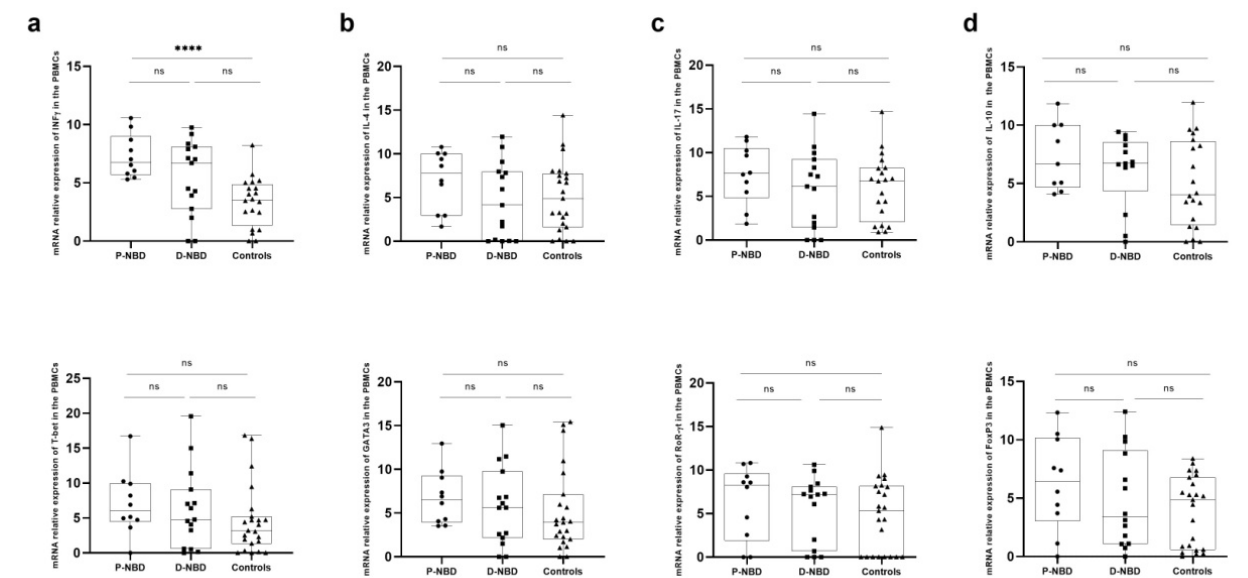
Figure 2. Boxplots representation of PBMCs Th1, Th2, Th17 and Treg related gene expression: ( a ) Representative boxplots of INF- γ and T-bet expression in the PBMCs of patients and NIND; ( b ) Representative boxplots of IL-4 and GATA3 expression in the PBMCs of patients and NIND; ( c ) Representative boxplots of IL-17 and RoR- γ t expression in the PBMCs of patients and NIND; ( d ) Representative boxplots of IL-10 and Foxp3 expression in the PBMCs of patients and NIND. Statistical significance between the two groups was assessed using the Wilcoxon–Mann–Whitney test ns = non significant, **** p < 0.0001.